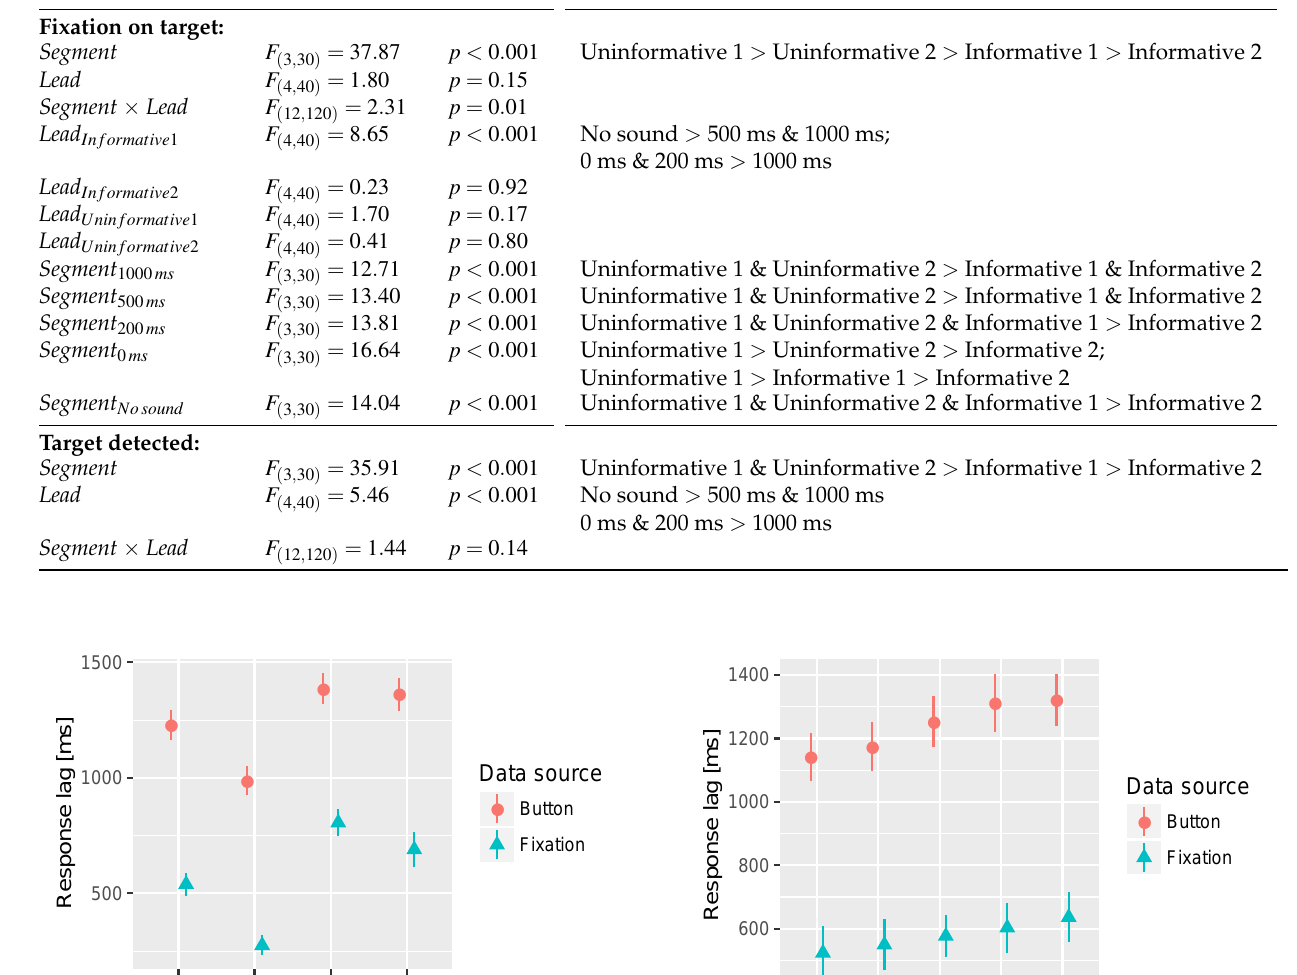
Main effects and significant post-hoc results with p < 0 . 05 .